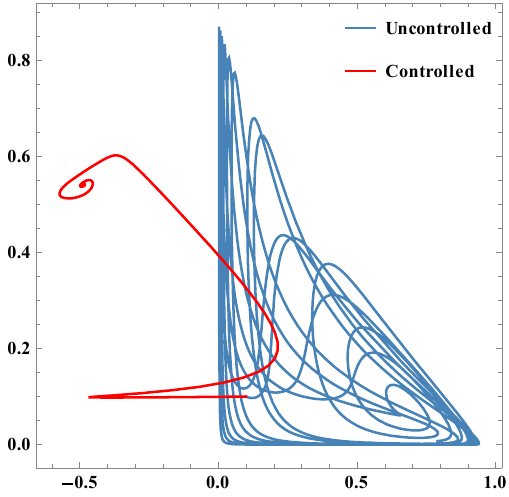
Figure 8. Parametric plots between x 2 & x 3 . Mathematics 2016 , 4 , 33